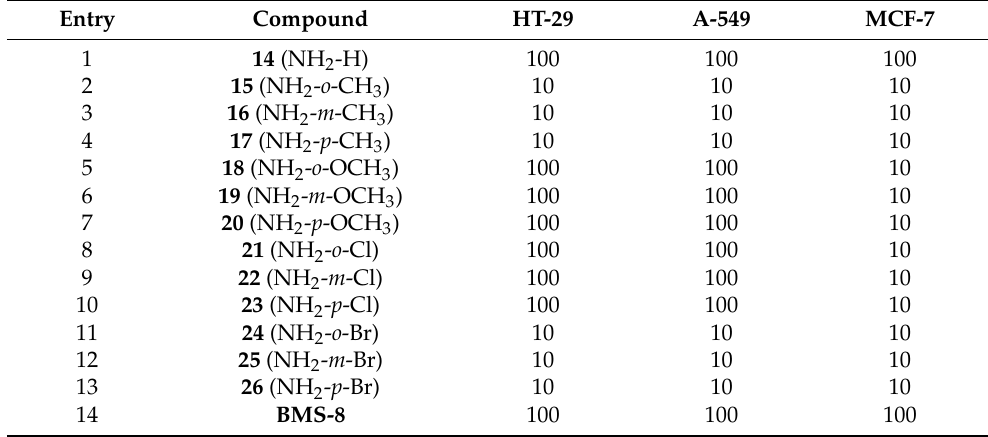
Table 7. Doses ( µ M) of tested compounds depending on the cell